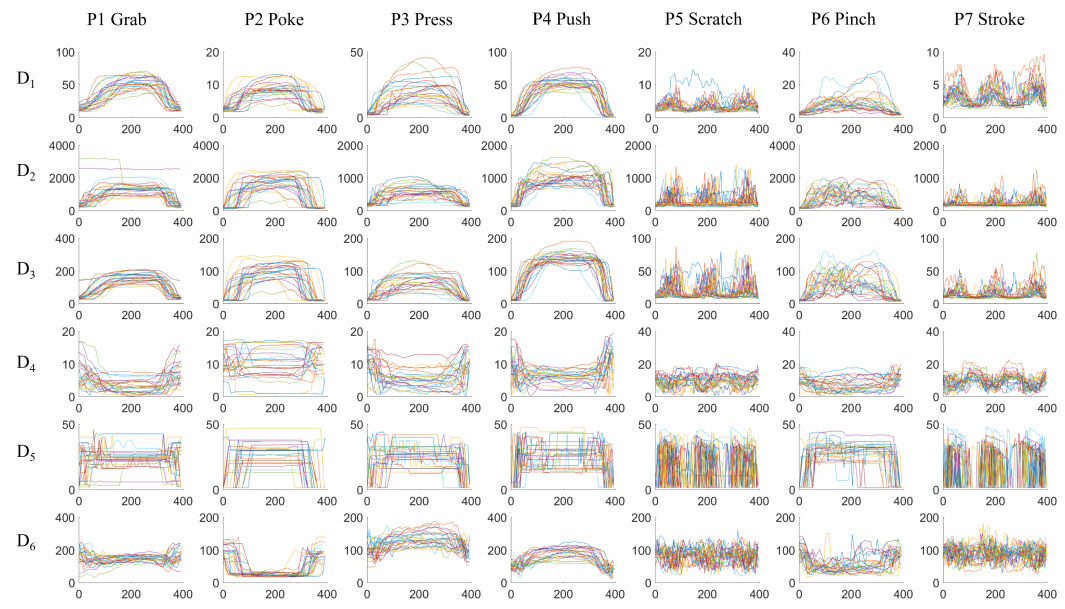
Figure 6. Comparison of the temporal sequence of frame descriptors from each class. Each curve is from a different person within Group A. The x-axis are sample in the temporal domain, the y-axis are scales of the values from different frame descriptors. The original data has different temporal length; in this plot they are scaled to the same 400-sample window using linear interpolation for visual